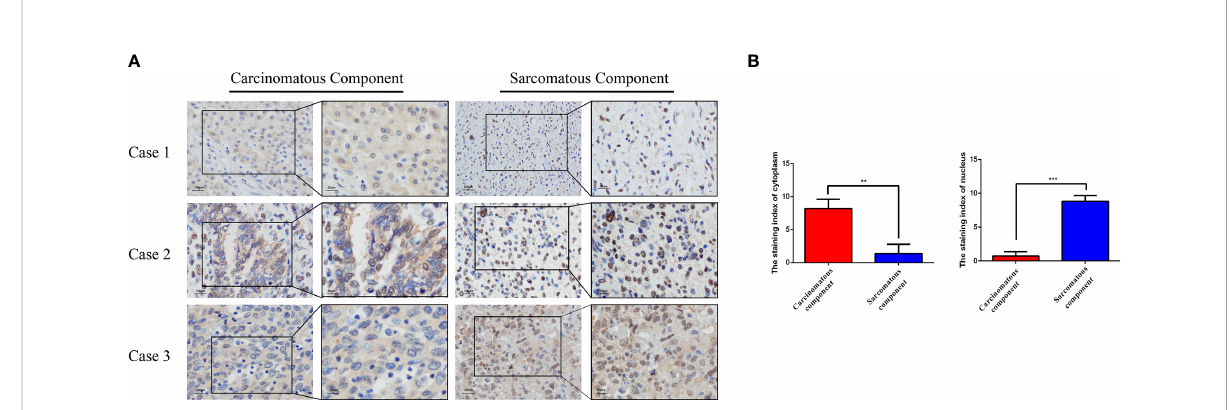
FIGURE 3 The expression of ZEB1 was examined in HCS tissues using IHC analysis. (A) Representative images of ZEB1 expression in the sarcomatous components and the carcinomatous components as detected by IHC analysis. (B) Statistical analysis of ZEB1 staining index in the sarcomatous components and the carcinomatous components of HCS tissues. ** P < 0.01, *** P <